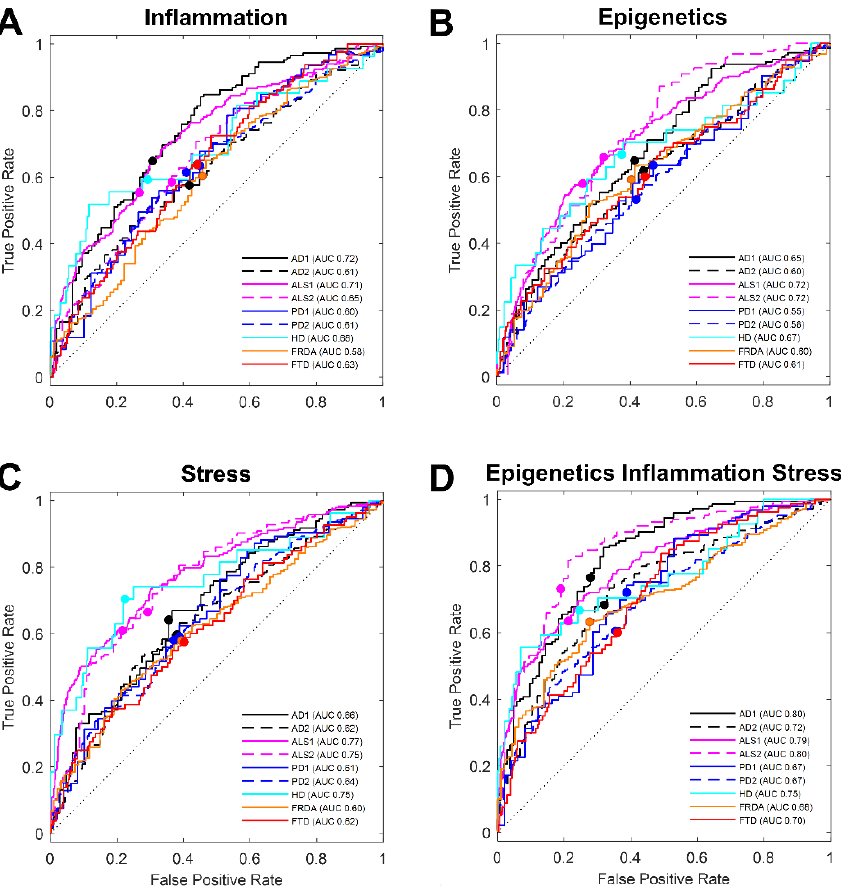
Figure 2. Receiver operator characteristic (ROC) curves for functional group features in AD and other neurodegenerative diseases. ROC curves generated from discriminant scores of linear discriminant analysis using group features selected empirically from literature for each of three functional groups ( A ) inflammation, ( B ) epigenetics, and ( C ) stress. ( D ) ROC curves for combined analysis of all 22 transcripts for the three groups. Line colors denote specific neurodegenerative disease tested and line points mark LDA selected threshold for each. ROC curve line color: AD (black), HD (cyan), FRDA (orange), PD (blue), ALS (pink), and FTD (red). AUC: area under curve probability for predicting classification of disease.